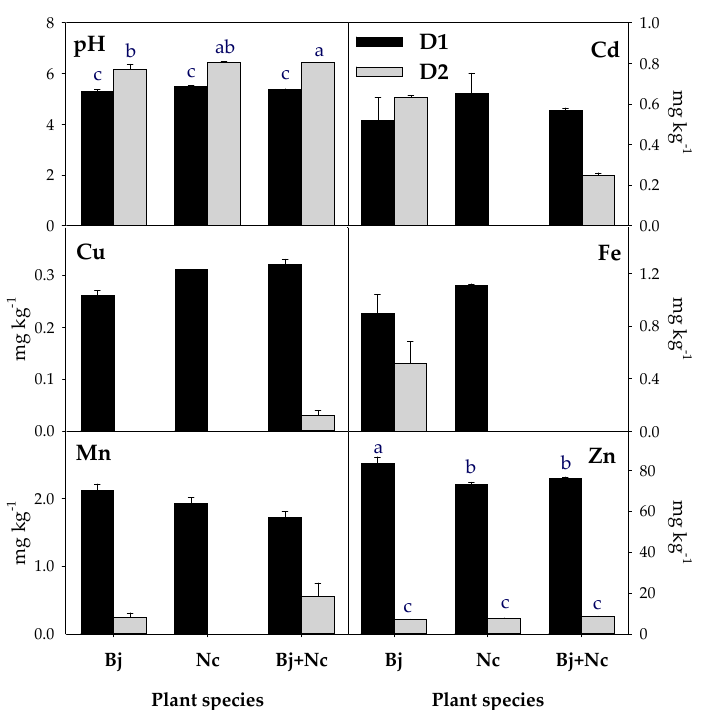
Figure 2. Soil pH values and concentrations of metals extracted with 0.1 M CaCl 2 solution in the soils where B. juncea (Bj), N. caerulescens (Nc), or B. juncea and N. caerulescens (Bj + Nc) were grown (mean values (dry soil basis) ± standard error). For each soil, bars marked with different letters indicate significant differences at p < 0.05, according to Tukey’s test. Bars without letters indicate that statistically significant differences were not found ( p > 0.05) for the same soil.